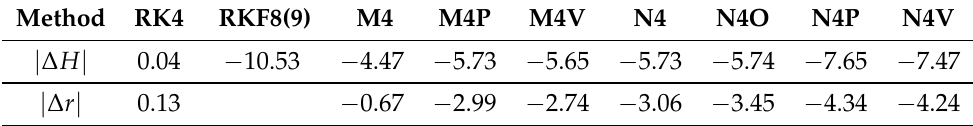
Figure 8. Energy and position errors in the spring pendulum problem. The step size is τ = 0.1, and energy is E = 1/12. Initial conditions are r = 1.15, p r = 0 and ϕ = 0.05 π . ( a ) Energy errors for the algorithms. ( b ) Position errors for the algorithms. These errors are clearly listed in Table 4. Table 4. Energy errors | ∆ H | and position errors | ∆ r | for the algorithms in Figure 8.